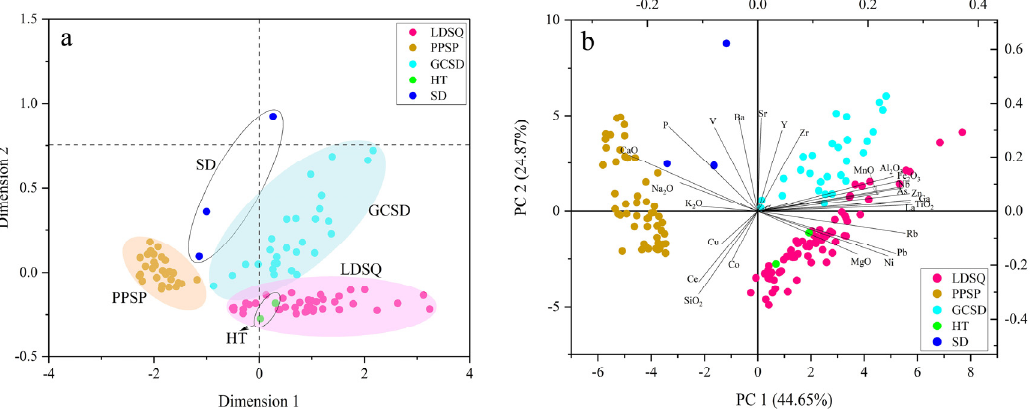
Figure 8. Scatter diagrams of multidimensional scaling analysis ( a ) and principal component analysis ( b ) for mobile dune, nebkha, and flood plain sediments in the Dinggye area.